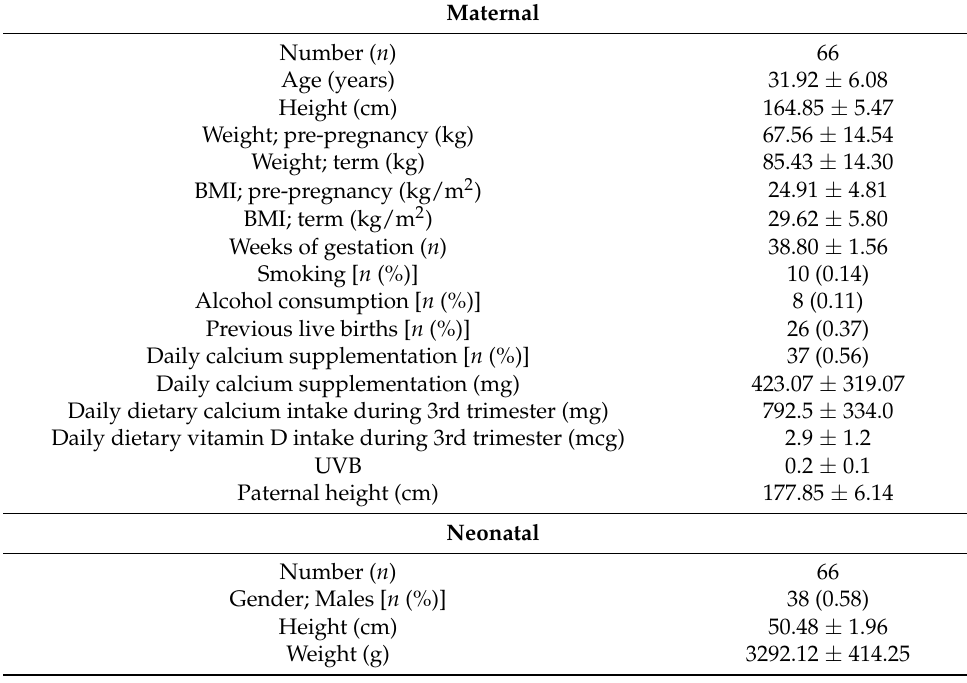
Table 1. Maternal and neonatal demographic and anthropometric characteristics.